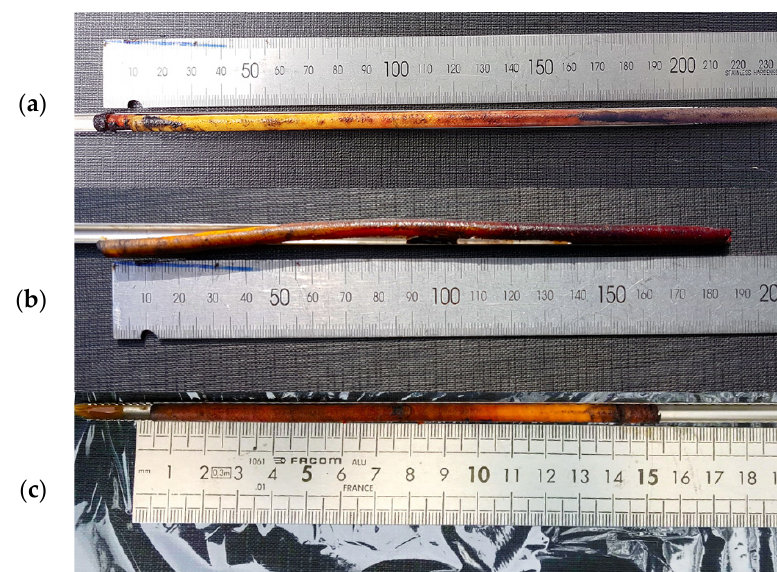
Figure 3. Differentiated sapwood and heartwood using PH indicator dye for the three species ( a ) C. maculata ( b ) M. styphelioides ( c ) L. confertus .